Question: Write the caption for this figure.
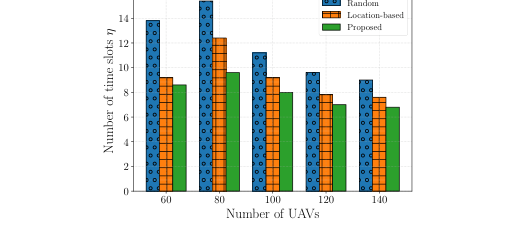
Answer: Number of time slots versus swarm size.